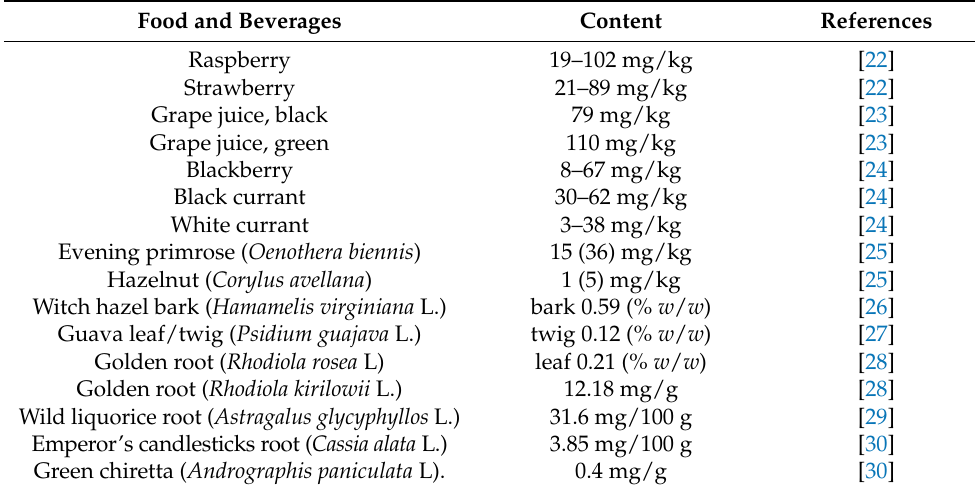
Table 2. The occurrence of gallic